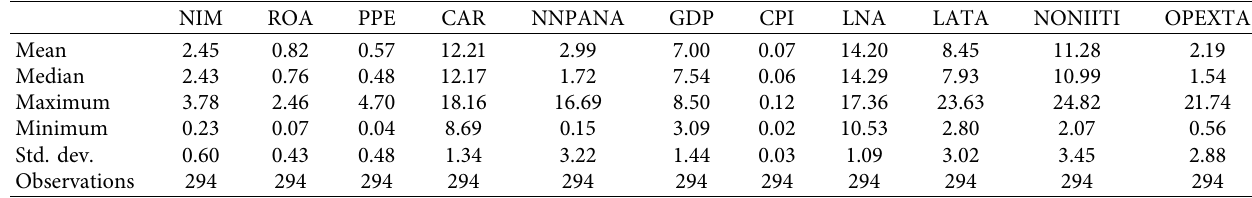
Table 3: Descriptive statistics.